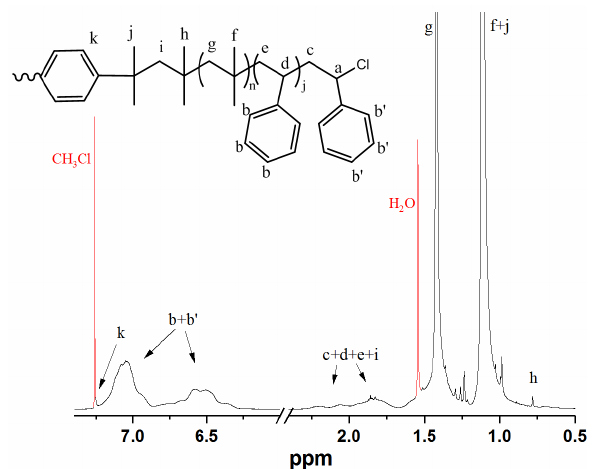
Figure A1. 1 H-NMR spectrum of SIBS.